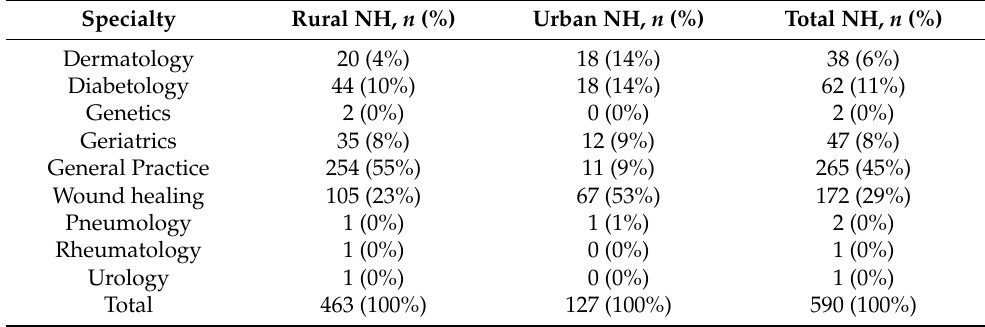
Table 2. Characteristics according to localization (rural or urban) performed between nursing homes and Troyes Hospital in France between 2018 and 2021.